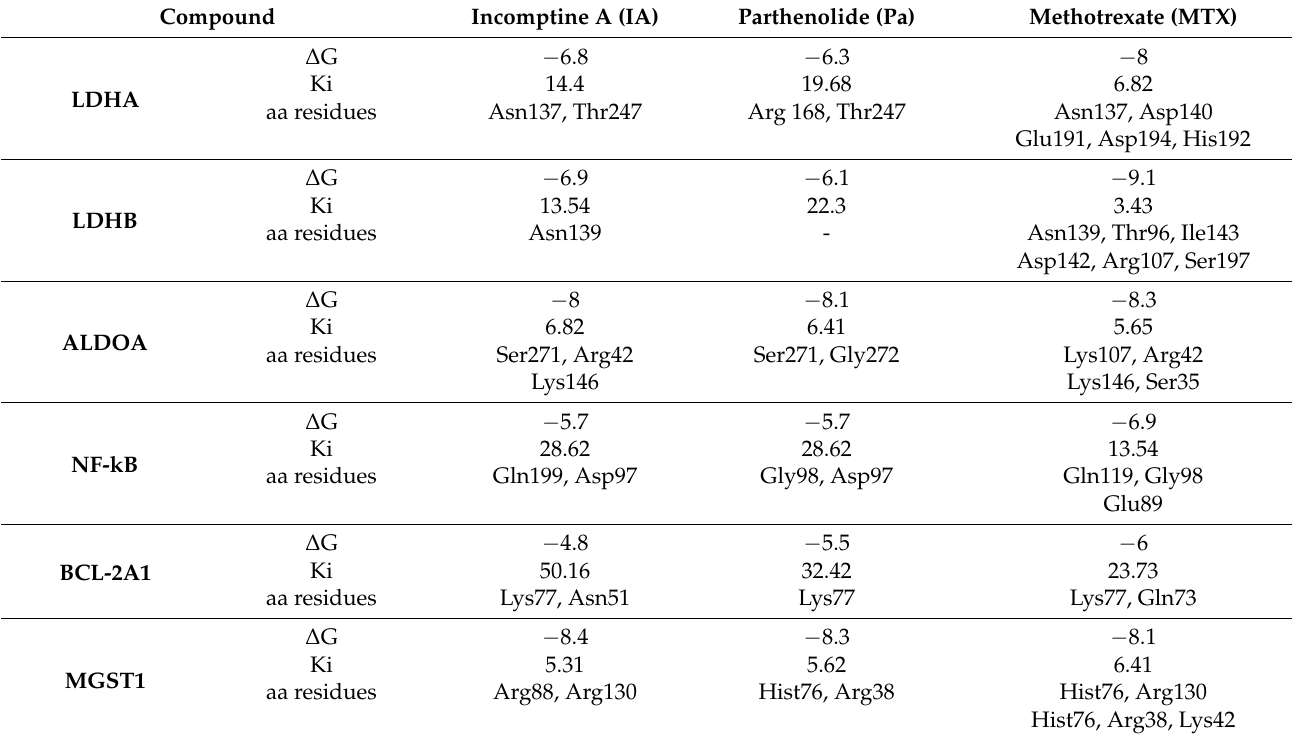
Table 2. ∆ G (kcal/mol), Ki (mM), and receptor–ligand interactions from molecular docking.